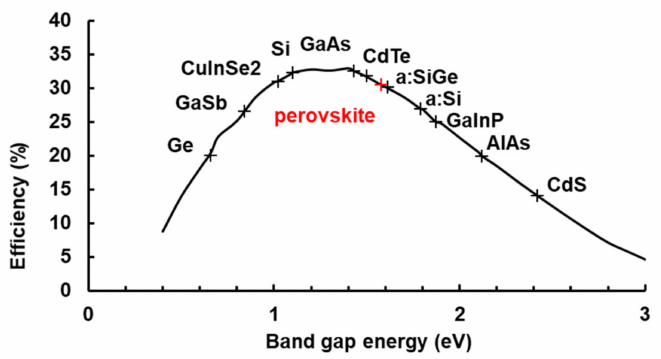
Figure 5. Theoretical efficiency limit for AM 1.5 spectrum, with various